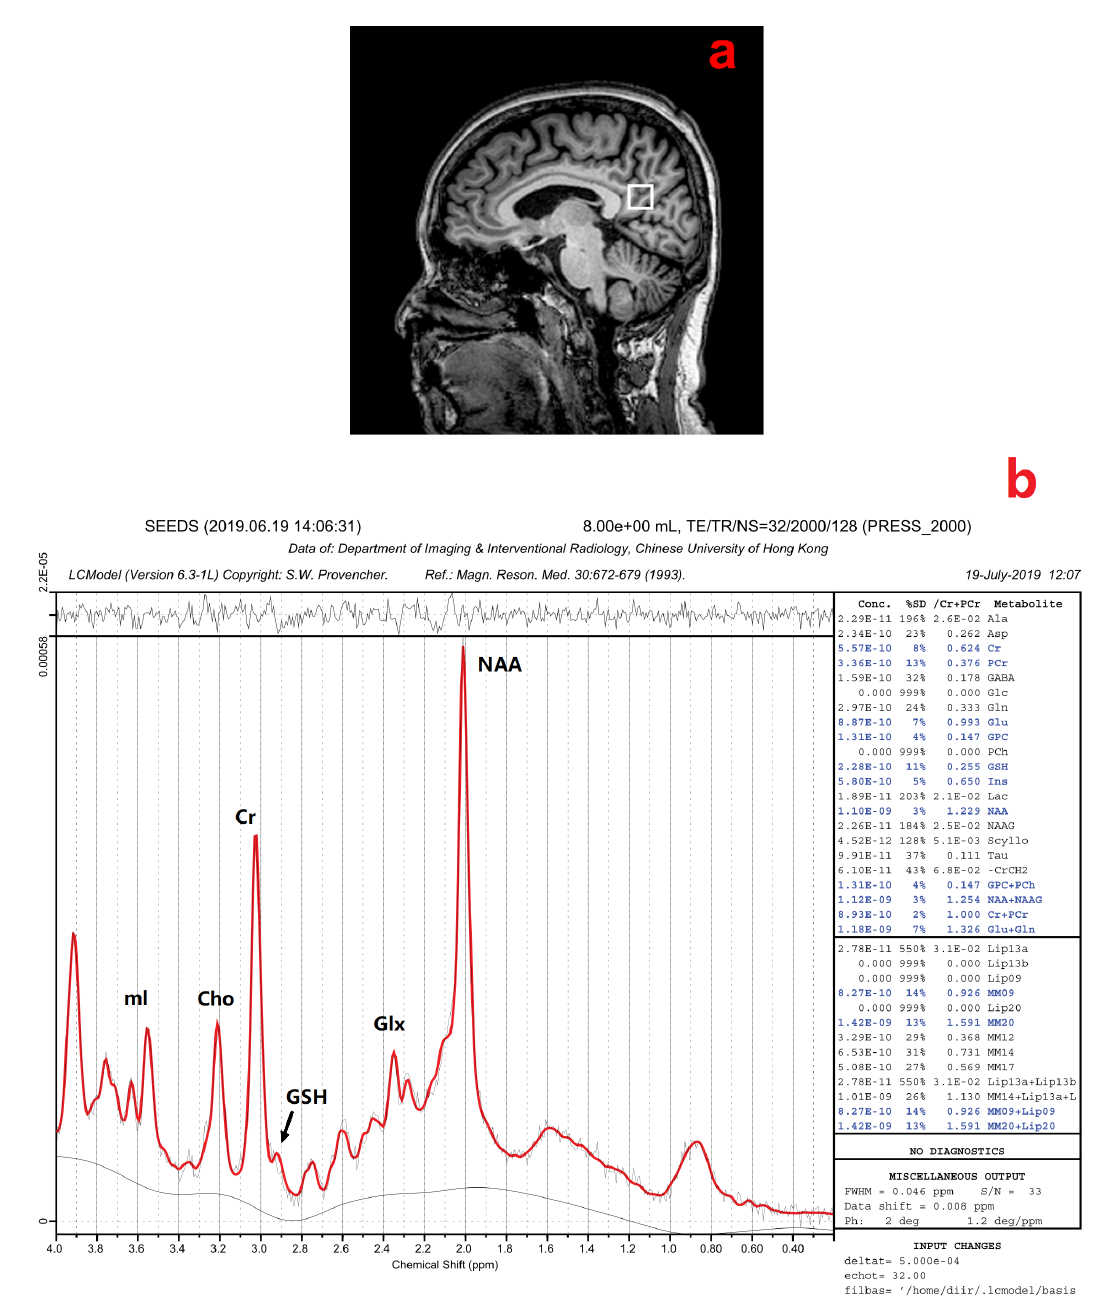
Figure 1. ( a ) Example of the 1 H-MRS voxel localization. ( b ) MR proton spectra. mI,